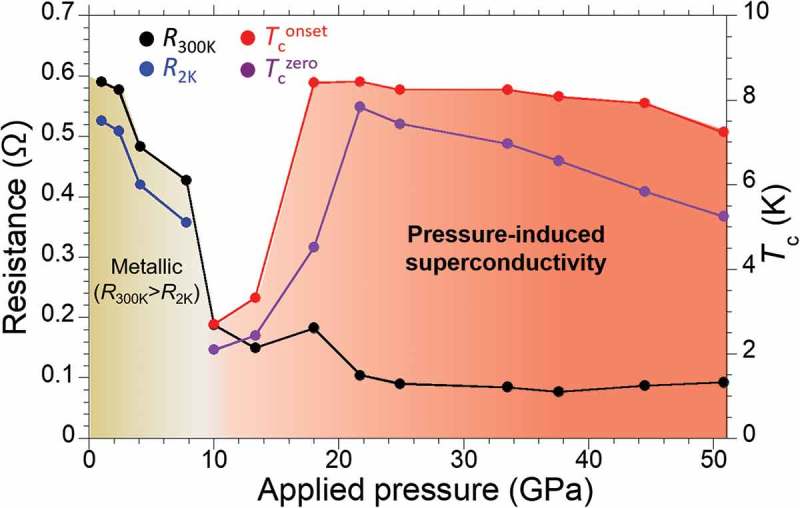
Resistance-pressure phase diagram of PbBi2Te4.